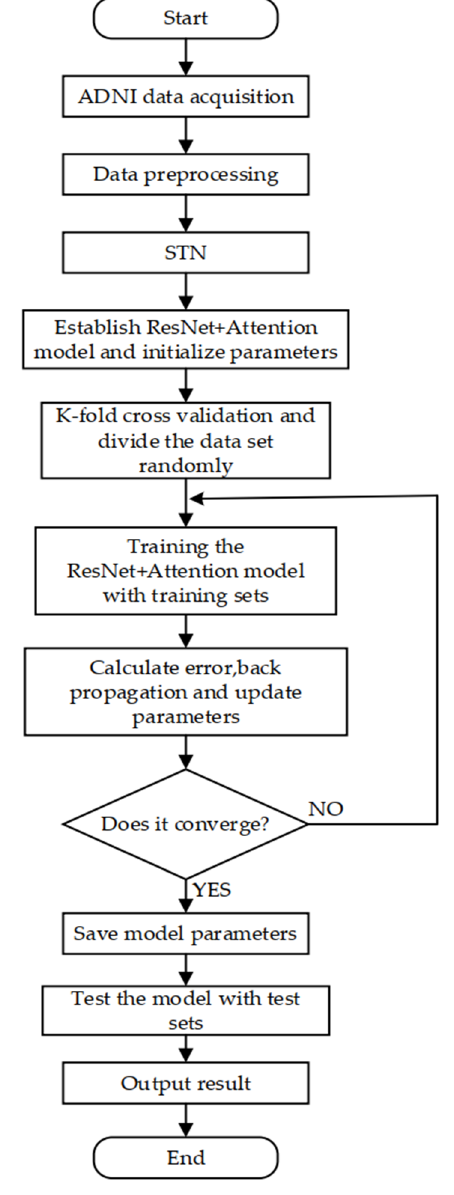
Figure 7. The detailed step flow chart.